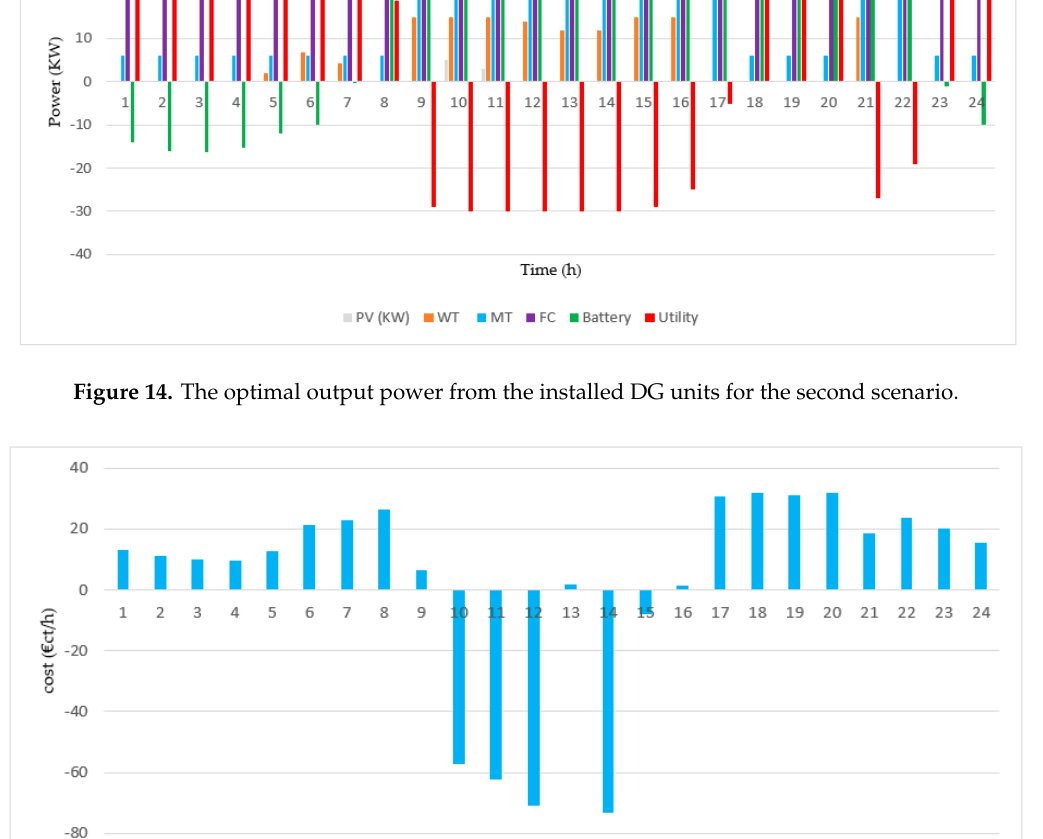
Figure 15. The optimal operation cost of the second scenario for each hour a day.